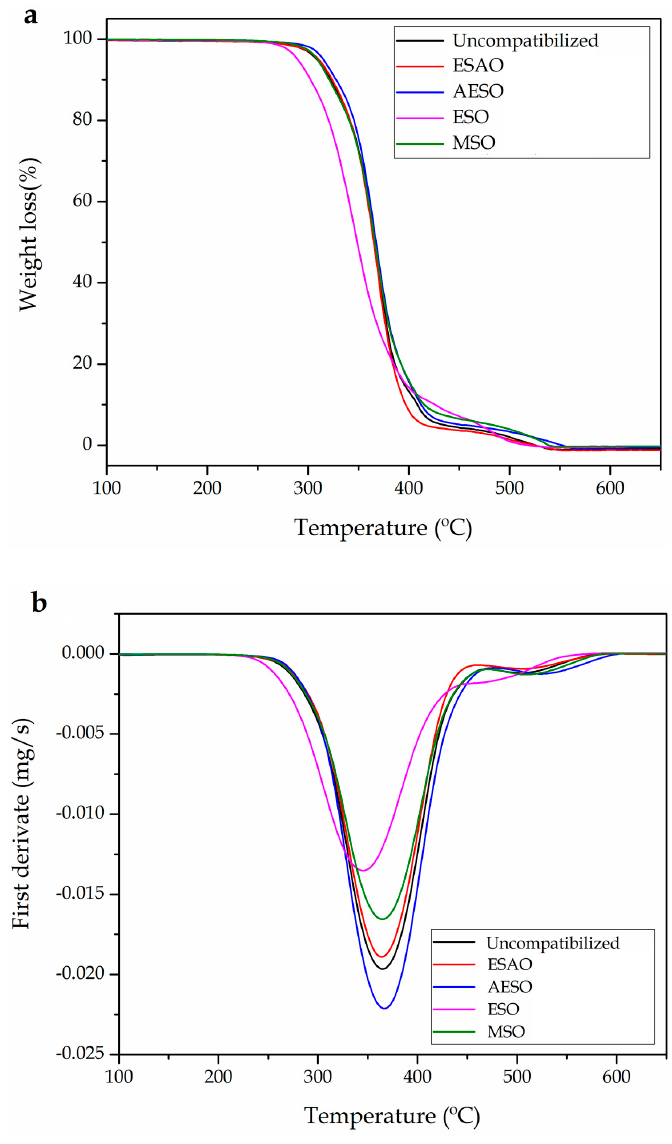
Figure 4. Comparative thermogravimetric (TGA) thermograms of PLA 60 /PHB 10 /PCL 30 blend with different compatibilizers, ( a ) weight loss and ( b ) DTG first derivative. Table 2. Main parameters of the thermal degradation of ternary PLA 60 /PHB 10 /PCL 30 blend with different compatibilizers, obtained by thermogravimetric analysis.